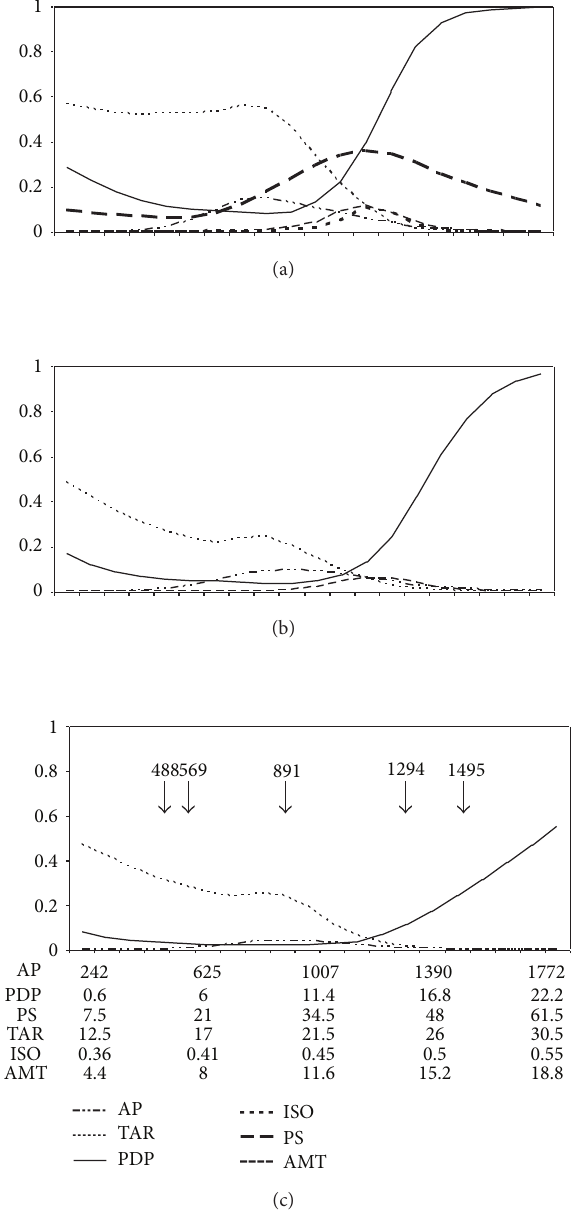
Figure 4: Generalized additive models of the bioclimatic distri- bution of Isoodon obesulus obesulus , based on (a) six variables, (b) four variables, and (c) three variables. 𝑦 -axis: probability of occurrence. 𝑥 -axis: BIOCLIM variables. AP (annual precipitation in mm: sum of all monthly precipitation estimates); PDP (precipitation of the driest period in mm interpolated weeks); PS (precipitation seasonality: Coefficient of Variation, the standard deviation of weekly precipitation estimates expressed as a percentage of the annual mean); TAR (temperature annual range in ∘ C: maximum temperature of the warmest week minus minimum temperature of the coldest week); ISO (isothermality: mean diurnal range (weekly maximum minus minimum) divided by temperature annual range); AMT (annual mean temperature in ∘ C: mean of all weekly mean temperatures, which are the mean of each week’s maximum and minimum temperatures). Arrows and numerals on (c) indicate values of AP illustrated in Figure 5.